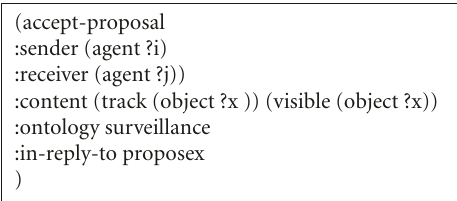
Figure 6: Relationship between received messages and fired plans.